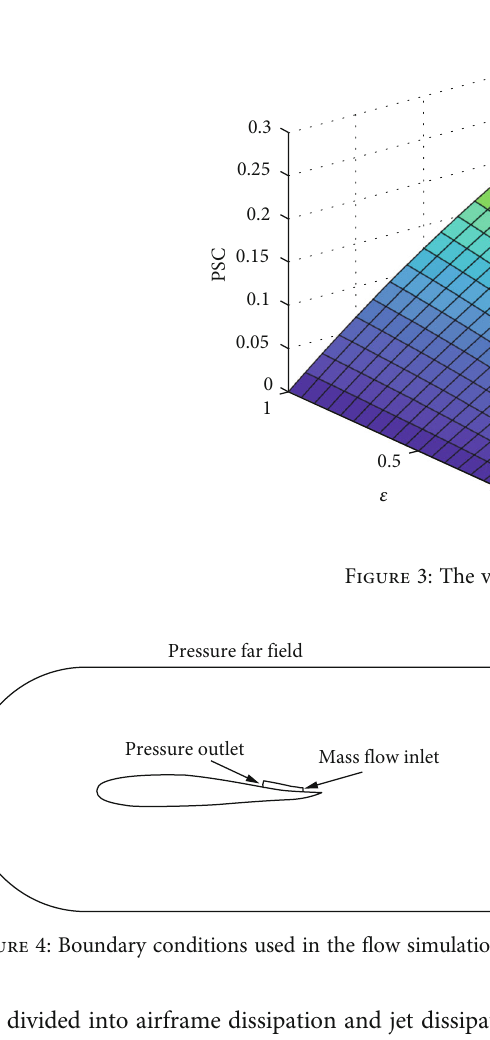
Figure 2: Distribution of di ff erent dissipation sources.